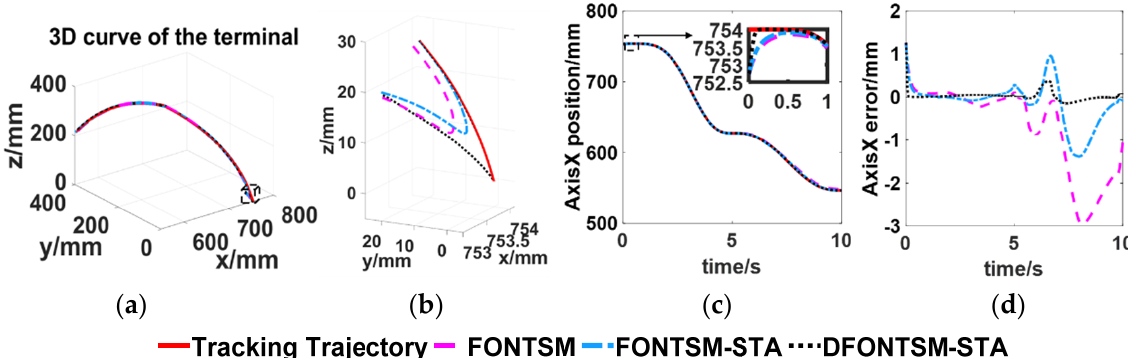
Figure 5. Terminal motion trajectory and its tracking error ( a ): Terminal trajectory tracking curve